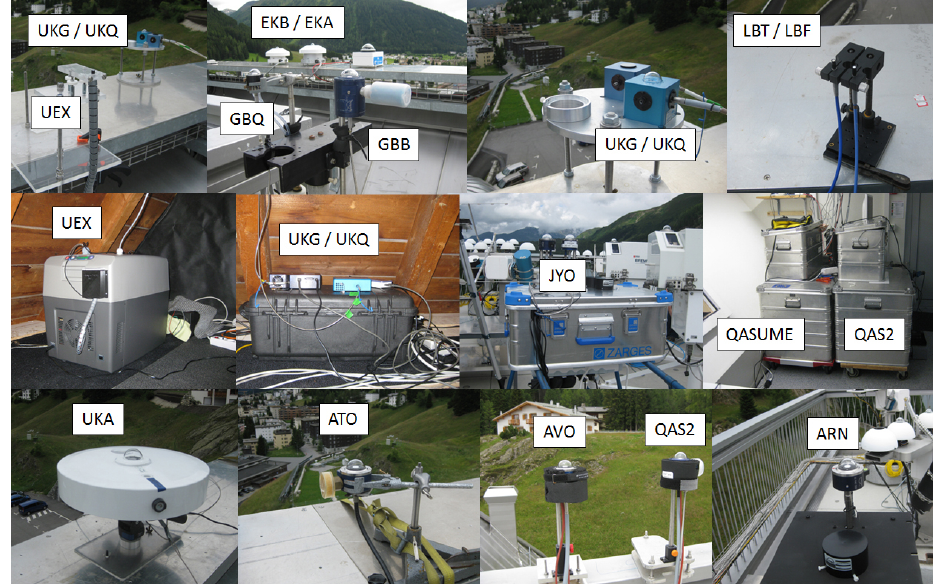
Figure 1. Fourteen array spectroradiometers installed on the measurement platform at PMOD/WRC in Davos, Switzerland. Some of the instruments were in weatherproof boxes on the roof, others were located inside the building under the roof and the entrance optics were connected to the instruments with an optical